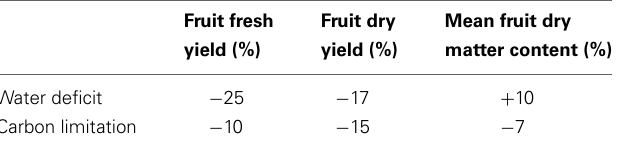
Table 1 | Predicted effect compared to control at the end of the simulation (160 days) on total yield (fresh, dry weight) and mean fruit dry content, in case of the application of a long stress treatment (water deficit, shade).